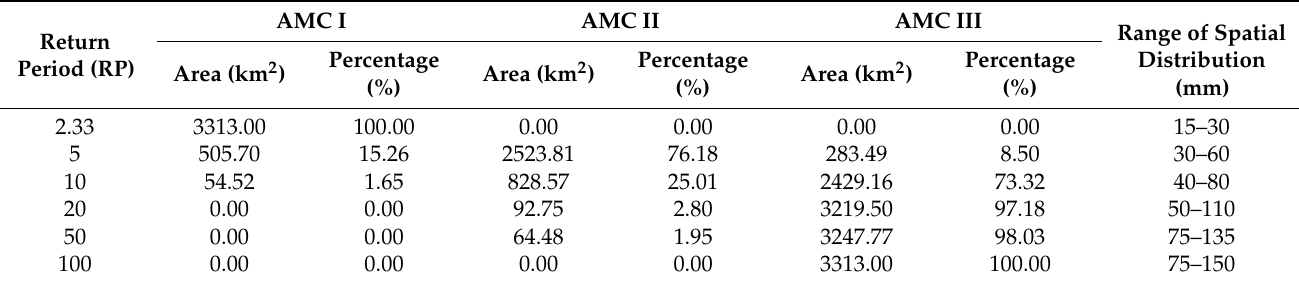
Figure 10. Spatial distribution of P prior-5d of the type of moisture conditions for a return period of 100 years. Table 8. Areas of moisture conditions AMC I, AMC II and AMC